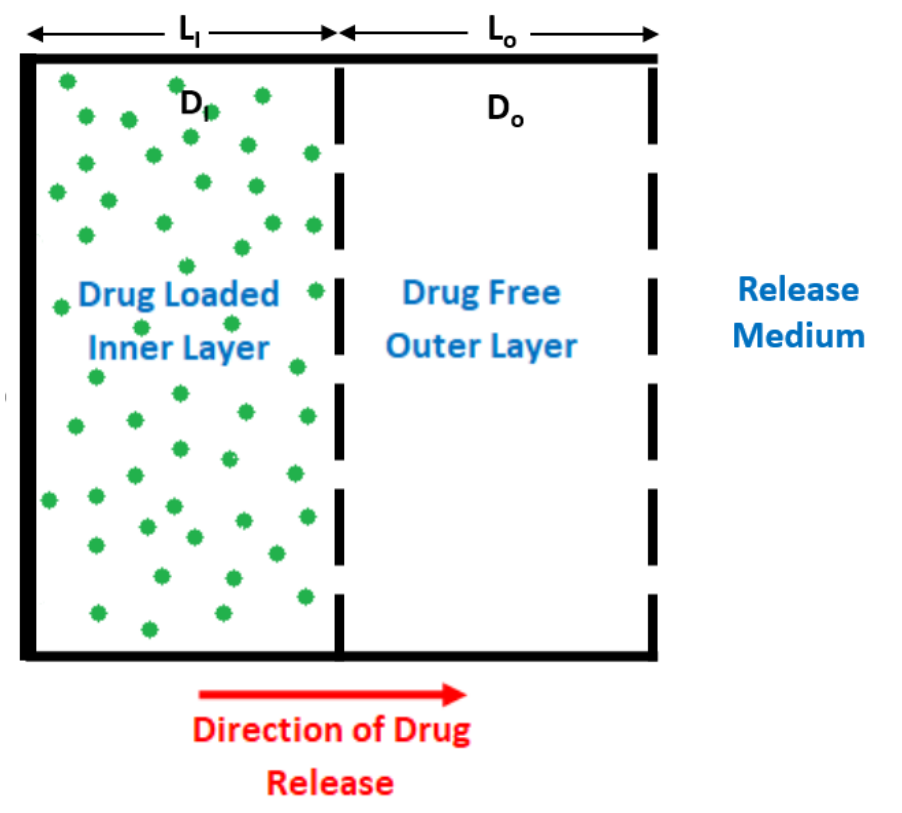
Figure 1. Schematic representation of the composite slab considered in our numerical simulations. The drug-loaded inner layer (drug-free outer layer) has thickness L I (L O ) and drug diffusion constant D I (D O ). Periodic boundary conditions are considered perpendicularly to the direction of drug release (for example, at the horizontal edges of the scheme). Reflecting boundary conditions are applied in the external boundary of the inner layer (thick vertical line, at the left surface of the slab), and therefore the drug can be only released through the external boundary of the outer layer (dashed vertical line, at the slab’s right surface).